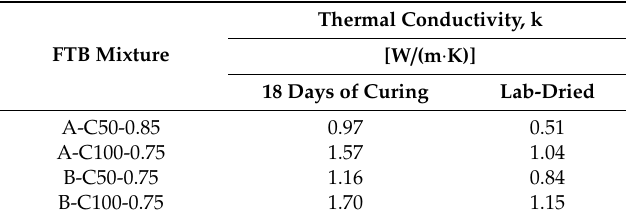
Table 8. Thermal conductivity of FTB